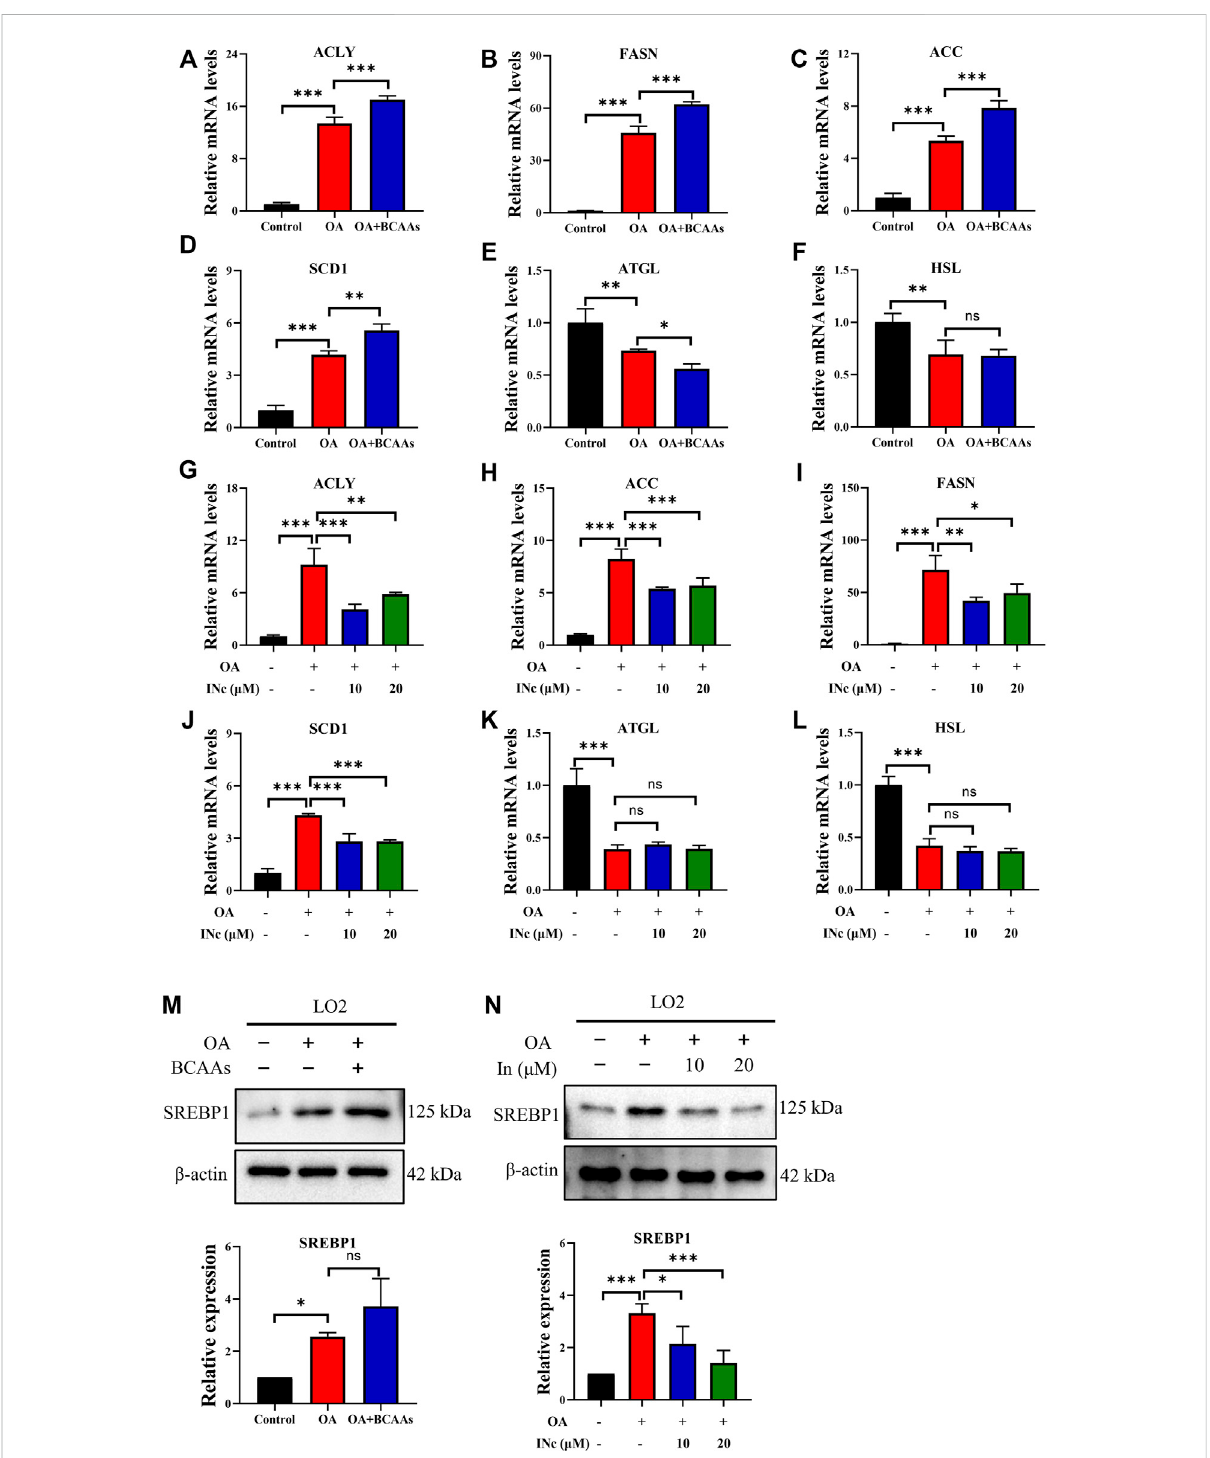
BCATc Inhibitor 2 alleviates OA-induced expression of lipogenesis-related genes. (A – F) LO2 cells were incubated with 0.5 mm Oleic acid with or without 10 mm BCAAs for 48 h qPCR was performed to determine the expression of ACLY (A) , FASN (B) , ACC (C) , SCD1 (D) , ATGL (E) , HSL (F) . (G – M) LO2 cells were incubated with 0.5 mM Oleic acid and 0, 10, 20 µM BCATc Inhibitor 2 for 48 h qPCR was performed to determine the expression of ACLY (G) , FASN (H) , ACC (I) , SCD1 (J) , ATGL (K) , HSL (L) . (M,N) LO2 cells were incubated with 0.5 mm Oleic acid with or